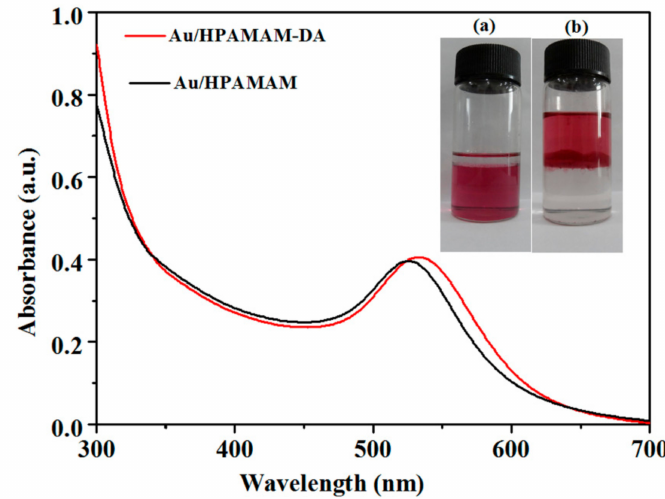
Figure 7. UV–Vis spectra of Au NPs encapsulated by HPAMAM–DA in a chloroform phase (Au / HPAMAM–DA) and released Au NPs in an aqueous phase (Au / HPAMAM). Inset: photo ( a ) and ( b ) correspond to Au / HPAMAM–DA in a chloroform phase and Au / HPAMAM nanocomposites in an aqueous phase,